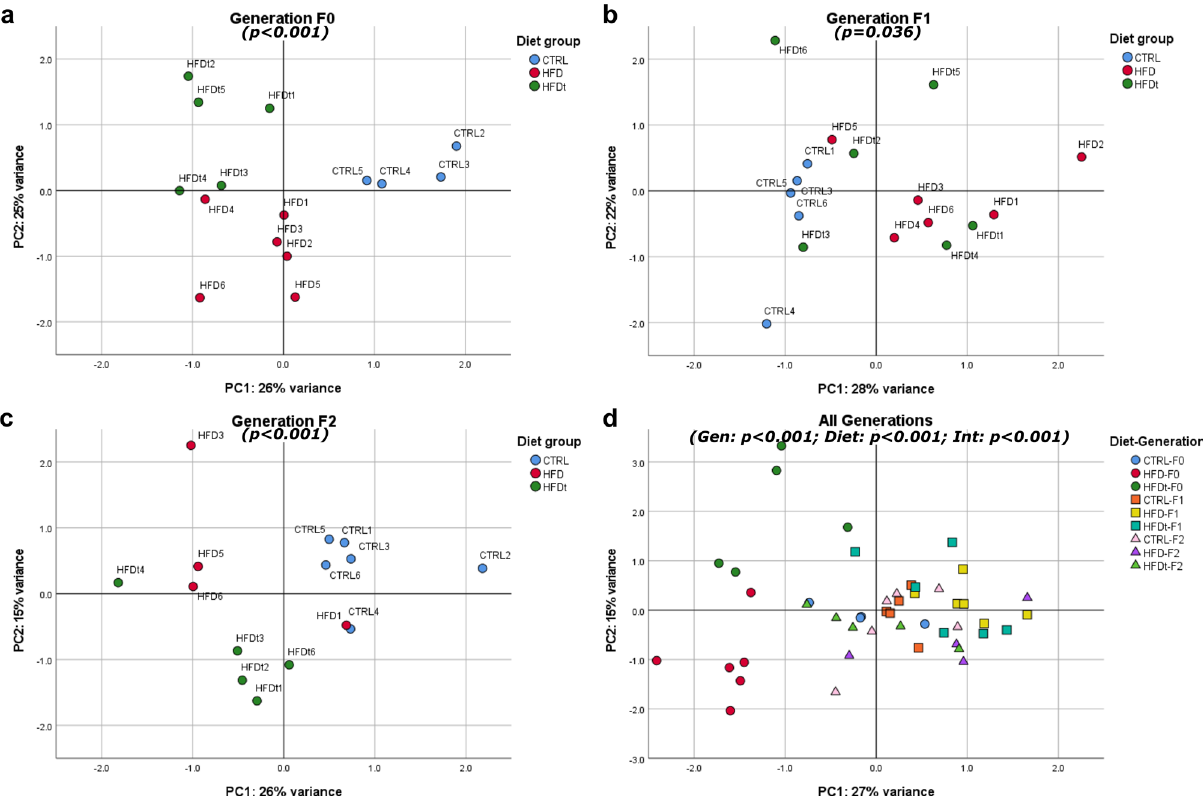
Figure 6. Sample dispersion in the two-dimensional space spanned by the two principal components extracted by PCA. Animals with at least one missing value in any of the variables considered (sperm parameters and testicular metabolites) were not included in the analysis. All the animals included in the model are represented in the graphs. Significance (p) values refer to overall permANOVA significance, obtained by the vegan R package. Significance was considered when adjusted p < 0.1. PC1 principal component 1, PC2 principal component 2, Gen generation factor, Int interaction (Generation*Diet) factor. PCA data visualization was obtained using the software SPSS 26 (Armonk, NY, USA) and edited using the software Inkscape 1.0 (Boston, MA,